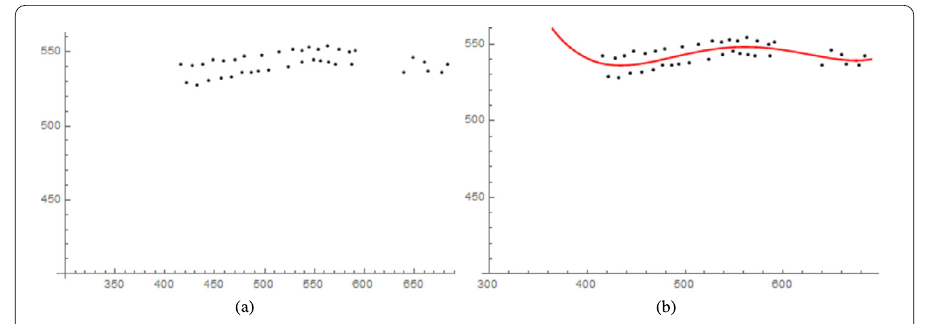
Figure 5 The points (eggs) are separated into the upper group and the lower group by curve fitting. ( a ) The original point; ( b ) the upper group and the lower